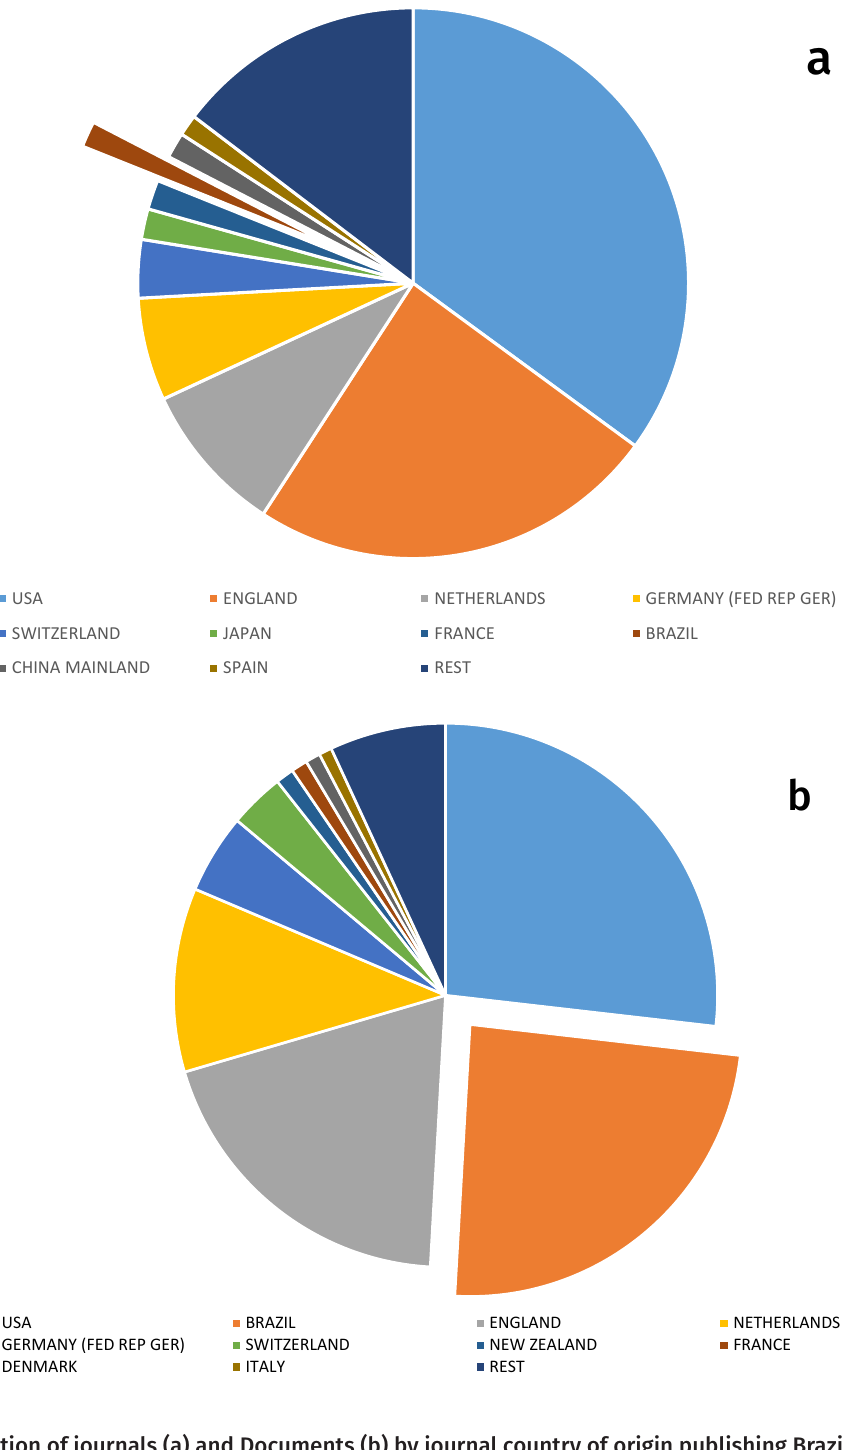
Figure 2. Distribution of journals (a) and Documents (b) by journal country of origin publishing Brazilian Authors (Incites ® 2009-2019). (Brazilian journals are highlighted in each